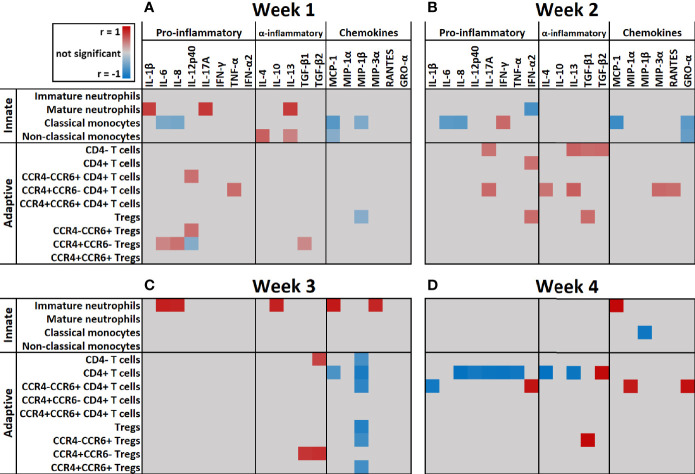
Heatmap of correlation coefficients of immune cells and soluble mediators over time. Significant (p < 0.05) correlation coefficients (r) of immune cell counts and fold change of soluble mediators at: (A) Week 1 (n = 13 patients); (B) Week 2 (n = 15 patients); (C) Week 3 (n = 10 patients); (D) Week 4 (n = 5 patients) after burn injury. Correlations were measured by Pearson tests and results are shown in gray (not significant), red (positive correlation) or blue (negative correlation).